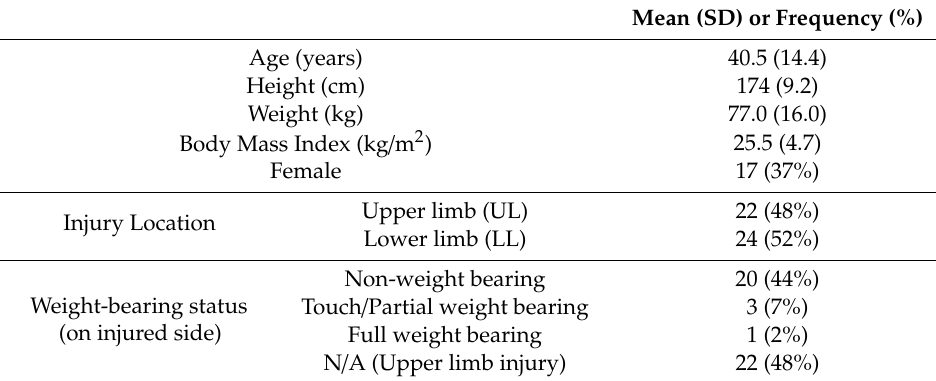
Table 1. Demographic characteristics of study sample ( n =